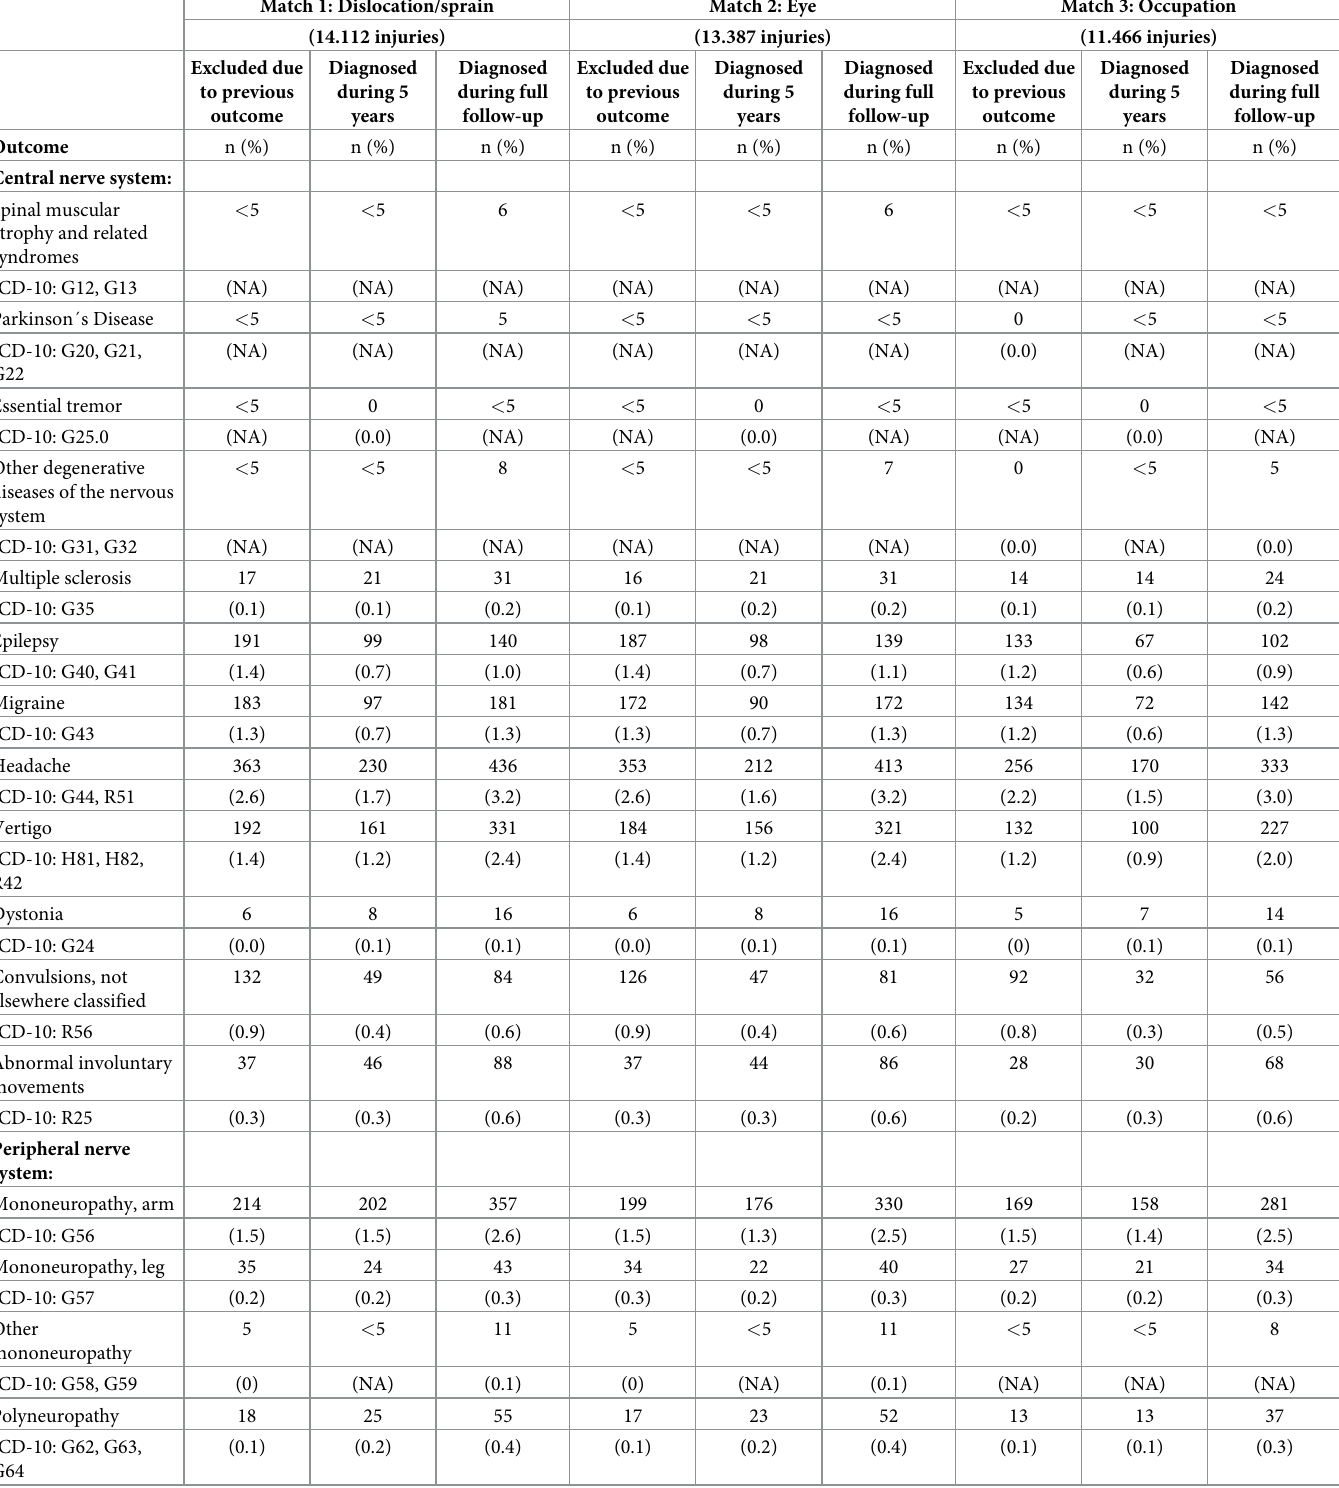
Table 1. Exclusions and diagnoses of electrical injured individuals for each of the three